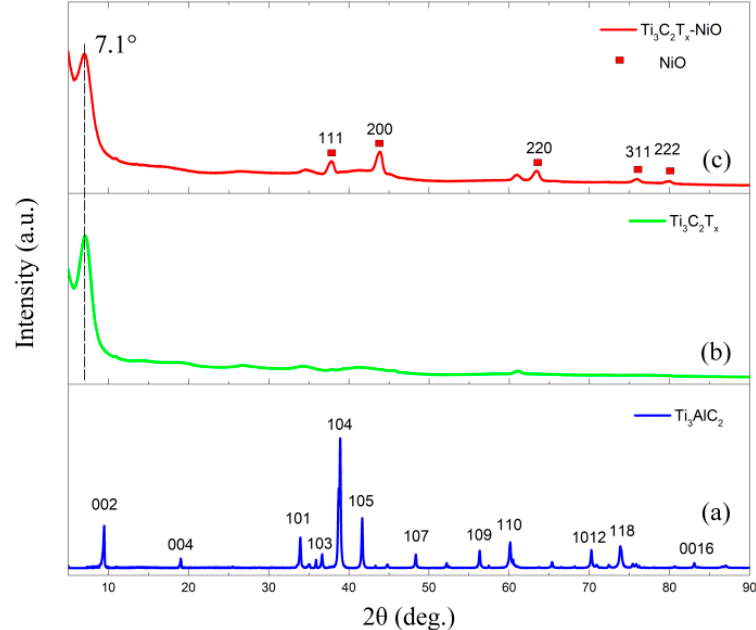
Figure 1. XRD patterns of ( a ) Ti 3 AlC 2 produced by hot pressing, ( b ) pure Ti 3 C 2 T x etched by LiF + HCl solution, and ( c ) 3D porous Ti 3 C 2 T x -NiO composite.